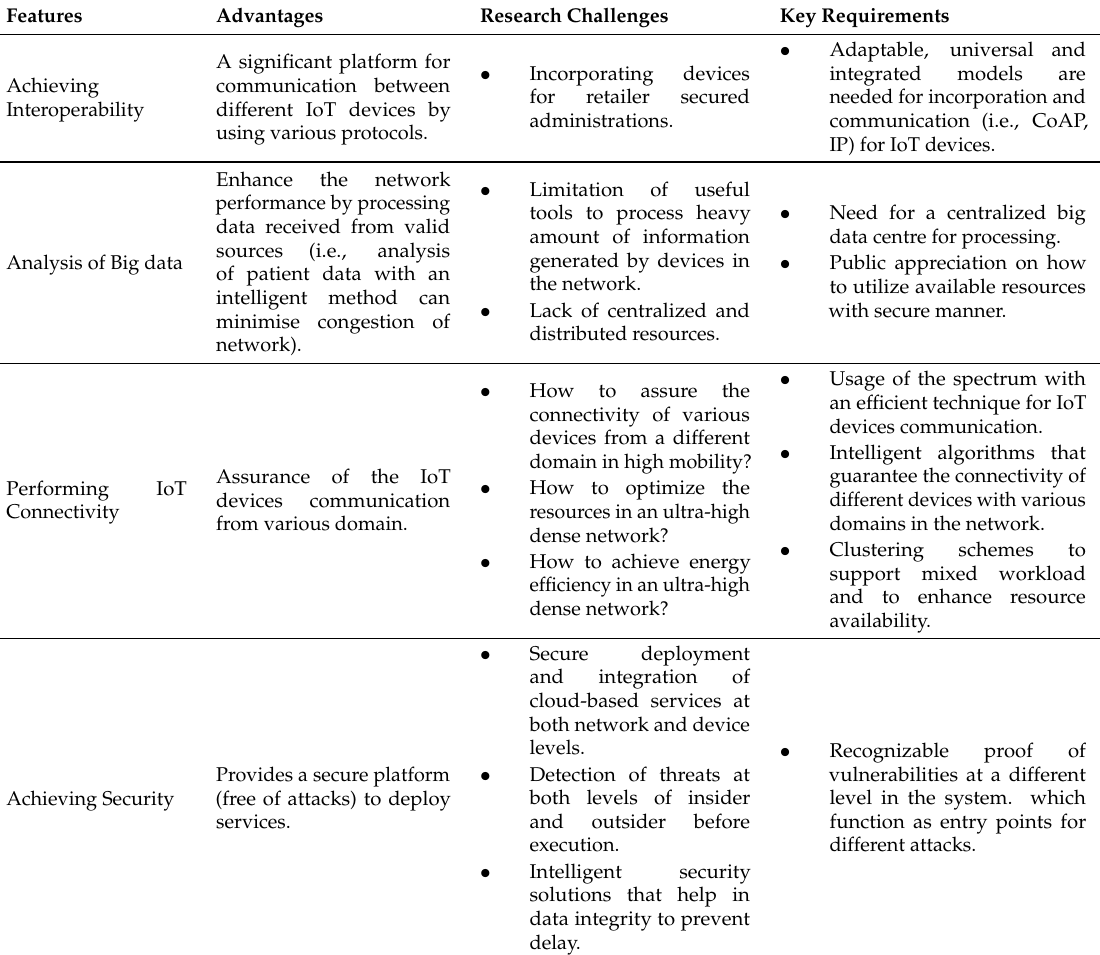
Table 5. Future research